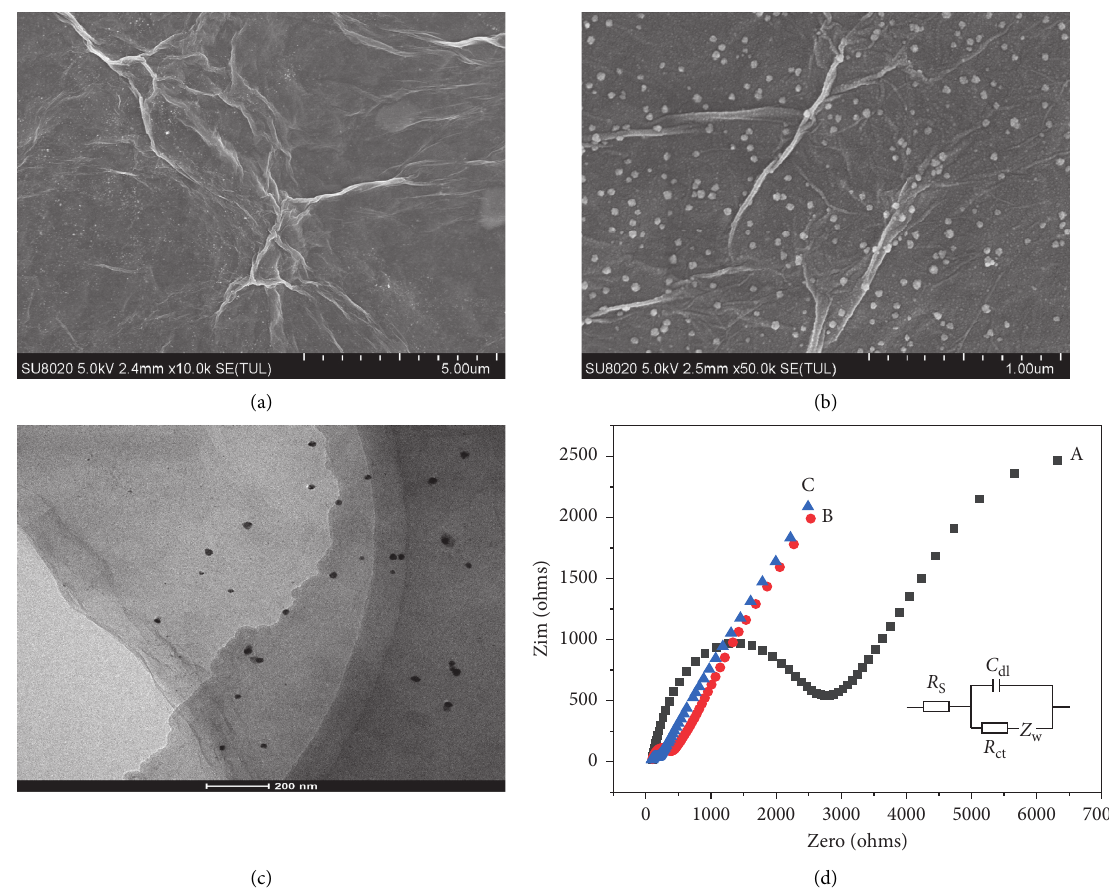
Figure 1: (a) FESEM characterization of rGO; (b) FESEM characterization of PdNPs/rGO nanocomposites; (c) HRETM characterization of PdNPs/rGO nanocomposites; (d) EIS characterization of bare GCE (A), rGO/GCE (B), and PdNPs/rGO/GCE (C) in 20mM potassium ferricyanide solution containing 0.1M